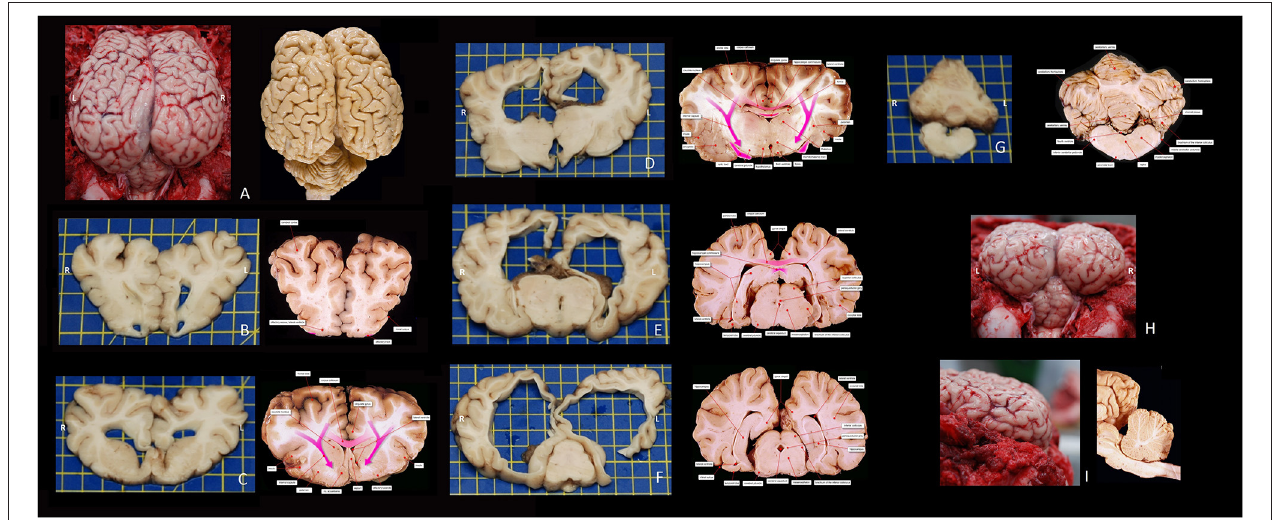
FIGURE 3 | Macroscopic photographs of the bovine encephalon of this case report and corresponding reference images (fixated in formalin) at approximately the same level–courtesy of dr. FG Wouterlood and dr. P. Voorn, Dept Anatomy and Neurosciences, AmsterdamUMC, VU, Amsterdam, The Netherlands. (A) Dorsal view of the cerebrum and cerebellum in situ after removal of the dorsal and caudal parts of the skull and dura mater. (B) Rostrocaudal view of a transverse slab at the level of the olfactory recesses. (C) Rostrocaudal view of a transverse slab at the level of the septal area. (D) Rostrocaudal view of a transverse slab at the level of the interthalamic adhesion. (E) Rostrocaudal view of a transverse slab at the level of the rostral mesencephalon. (F) Rostrocaudal view of a transverse slab at the level of the caudal mesencephalon. (G) Rostrocaudal view of a transverse slab at the level of the cerebellum, fourth ventricle, and medulla. (H) Caudorostral view of the cerebrum and cerebellum in situ after removal of the dorsal and caudal parts of the skull and dura mater. (I) laterolateral view of the cerebrum in situ after removal of the dorsal and caudal parts of the skull and dura mater. The anatomical terms differ from those of the Nomina Anatomica Veterinaria, as the images are composed and labeled by human